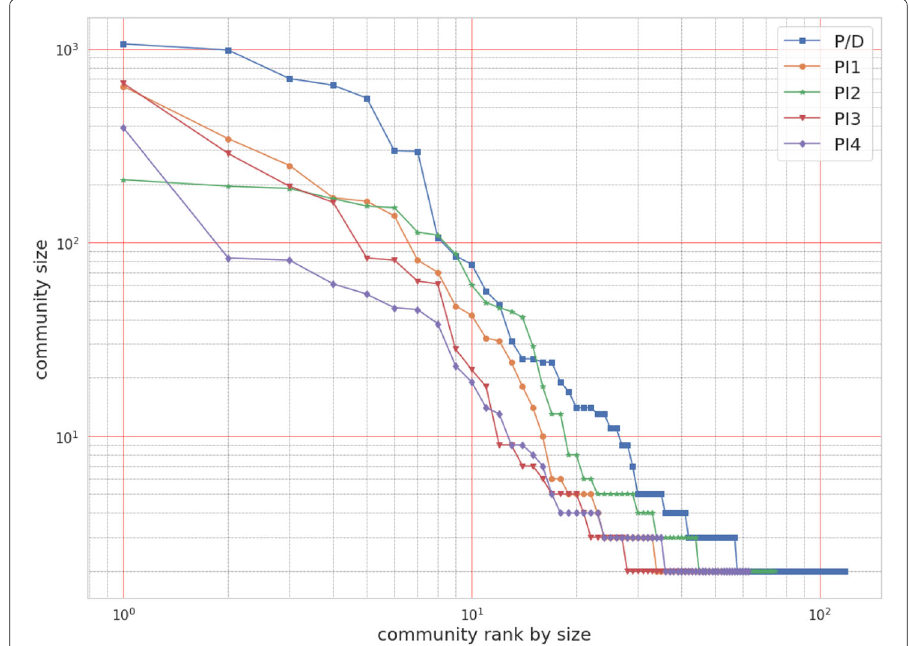
Fig. 4 Comparison of the clustering structure (cluster size distribution) for different propaganda graphs